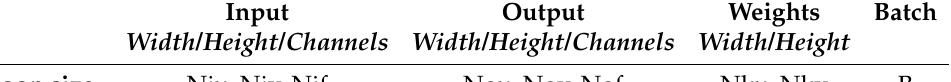
Table 1. Notation used in this work for loop dimensions, tiling factors, and unrolling factors.